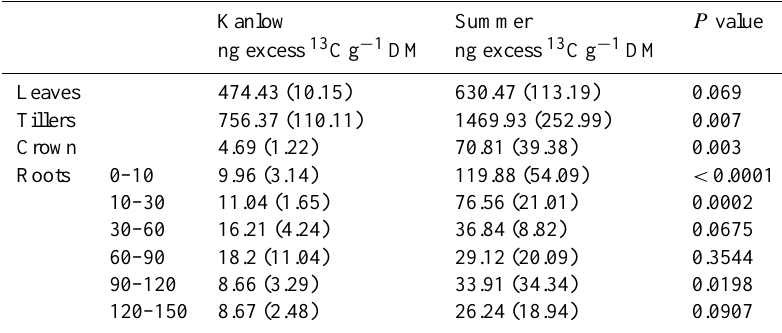
Table 4. The 13 C enrichment of aboveground plant biomass and belowground root biomass (ng 13 Cg − 1 plant biomass) plus standard deviation (in parentheses) for both switchgrass ecotypes Kanlow and Summer. P values equal to or below 0.05 indicate significant difference between ecotypes withineach soil depth. DM: dry matter biomass (0%